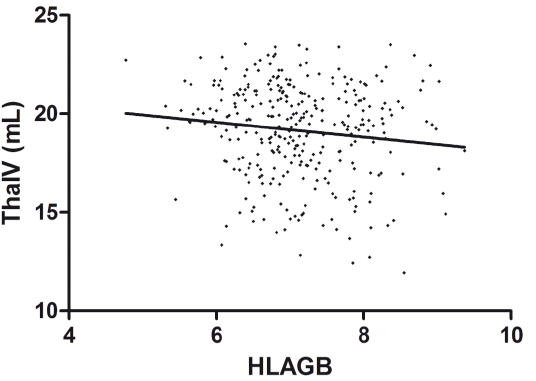
Figure 1. Correlation between HLAGB and thalamic volume. Scatter plot of the HLAGB and thalamic volume (ThalV) with an overlaid regression line. Each dot corresponds to a patient.